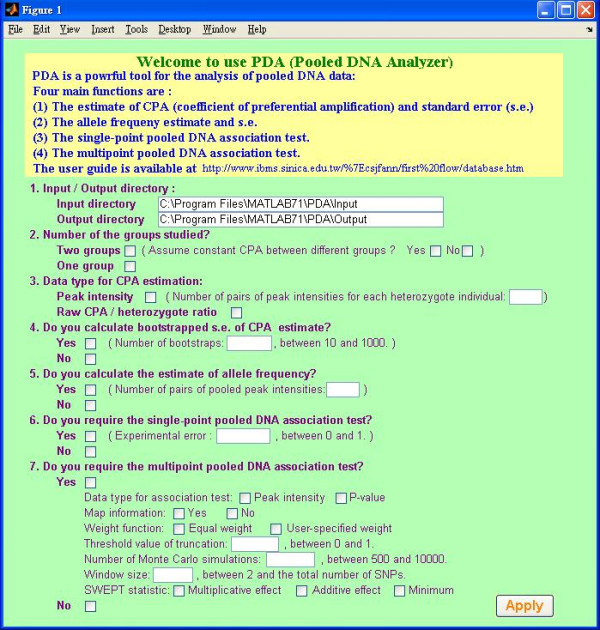
Interface of PDA.